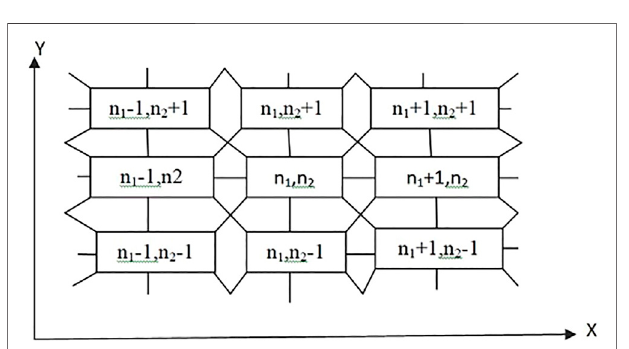
FIGURE 2 | Basic particular unit is identi fi ed by the two integers n=(n 1 , n 2 ), which represent the position of the unit within the structure ( two dimensional periodic plate) as an assembly of the periodic fl at panel joined together on all sides and